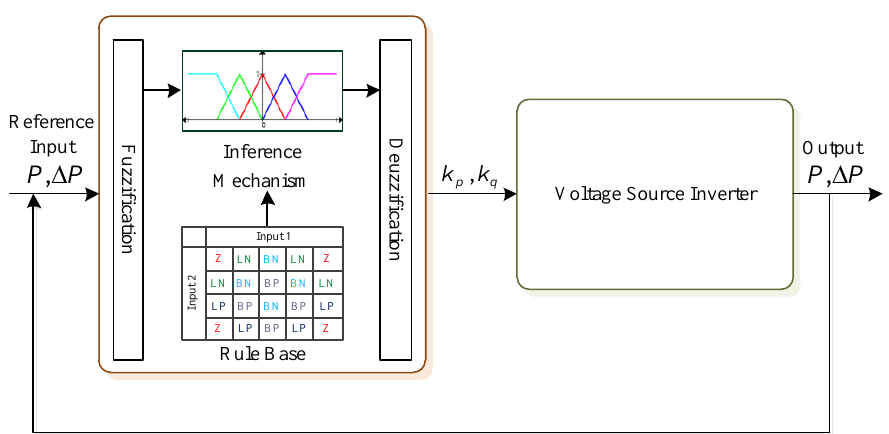
Figure 9. Basic block representation of the fuzzy inference process.